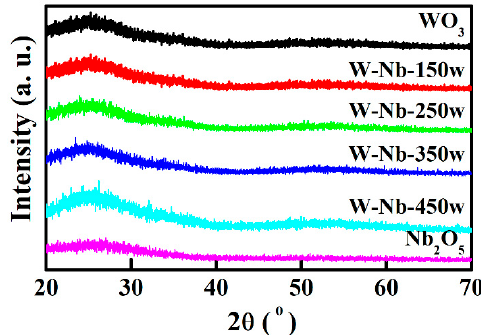
Figure 4. XRD patterns of WO 3 , WO 3 –Nb 2 O 5 , and Nb 2 O 5 films.